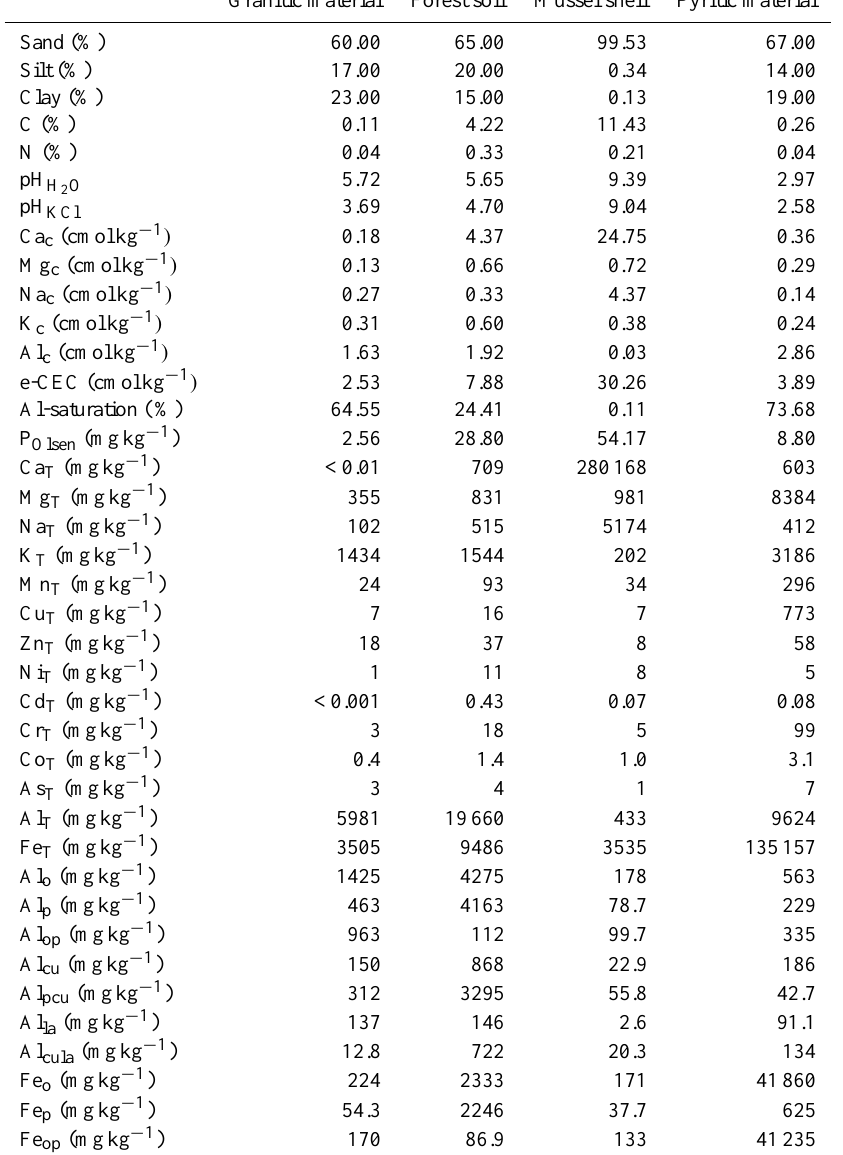
Table 2. General characteristics of the solid materials (average values for three replicates, with coefficients of variation always <5%). Granitic material Forest soil Mussel shell Pyritic